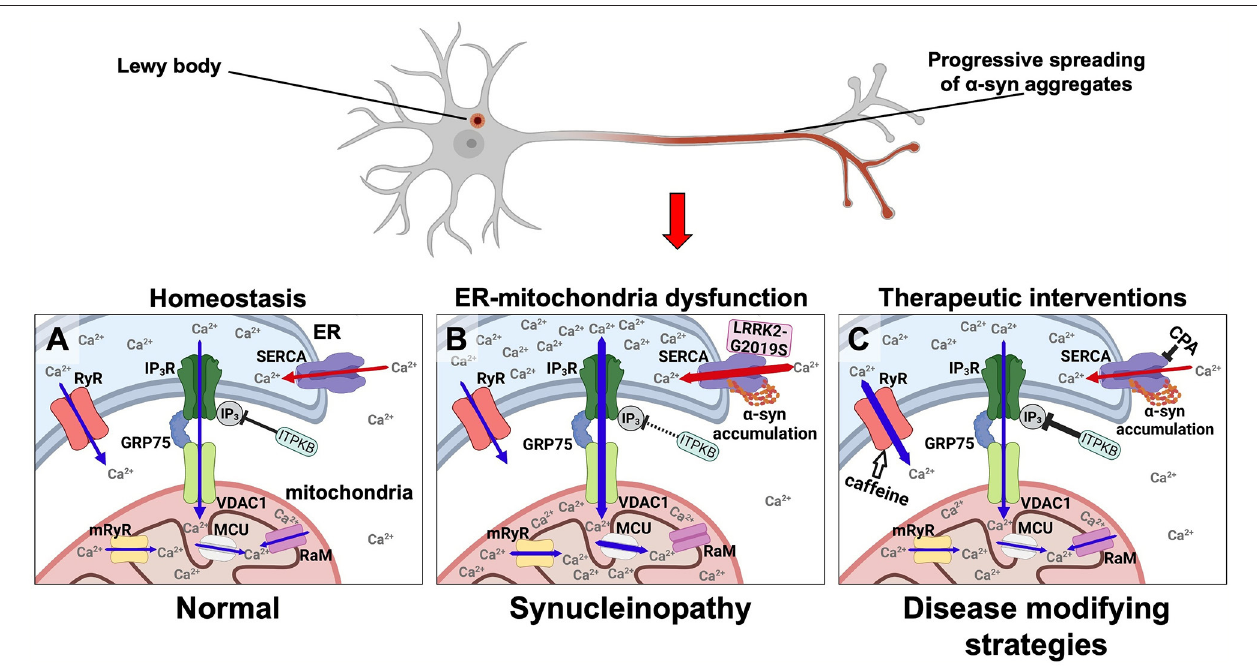
FIGURE 1 | Disease modifying strategies for synucleinopathies by modulating aberrant Ca 2 + fluxes in ER and mitochondria via targeting the SERCA pump, the RyR, and the ER-mitochondrial transport complex. α -syn is under normal conditions predominantly located in nerve terminals. In synucleinopathies, its initial aggregation is hypothesized to initiate at this site. From here, aggregates are transported retrograde through the axon to the cell body where Lewy bodies can form. (A) In healthy neurons the low resting Ca 2 + level in the cytosol and the high Ca 2 + levels in the ER and mitochondria are tuned by (1) the SERCA pump loading the ER with Ca 2 + from the cytosol (red arrows), (2) the release of Ca 2 + from ER to the cytosol by RyR and IP 3 R (blue arrows), (3) where the latter is part of the multi-molecular Ca 2 + funnel between ER lumen and the mitochondrial matrix (IP 3 R, GRP75, VDAC1, mRyR, MCU, and RaM). (B) In synucleinopathies, the α -syn aggregates activate SERCA causing an increased Ca 2 + uptake into the ER thereby deregulating ER functions and increasing the Ca 2 + flux through the IP 3 R-GRP75-VDAC1 complex and MCU into mitochondria. These increased Ca 2 + fluxes into ER and mitochondria along with a decreased cytosolic Ca 2 + concentration result in a reduced functionality and viability of neurons in synucleinopathies. The same pathways can be activated by mutant LRRK2-G2019S that activates SERCA and by loss-of-function genetic risk variants in the ITPKB kinase that increases the IP 3 -dependent Ca 2 + flux from ER to mitochondria. (C) These abnormal Ca 2 + fluxes can be counteracted as a disease modifying strategy in synucleinopathies. The α -syn activated SERCA can be inhibited e.g., by CPA. The Ca 2 + flux from ER to mitochondria can for example be attenuated by stimulating ITPKB or inhibiting the IP 4 phosphatase. The Ca 2 + flux from ER into the cytosol can be stimulated by caffeine (white arrow) or other RyR